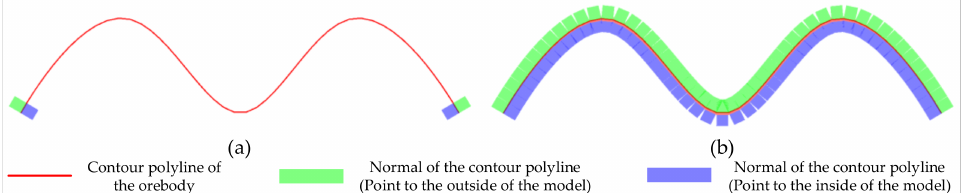
Figure 5. Linear interpolation. ( a , b ) show the comparison before and after linear